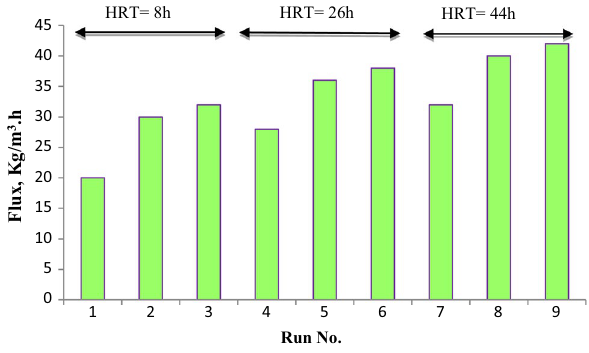
Fig. 3 Flux variations of 0.1 wt% of PES/NH